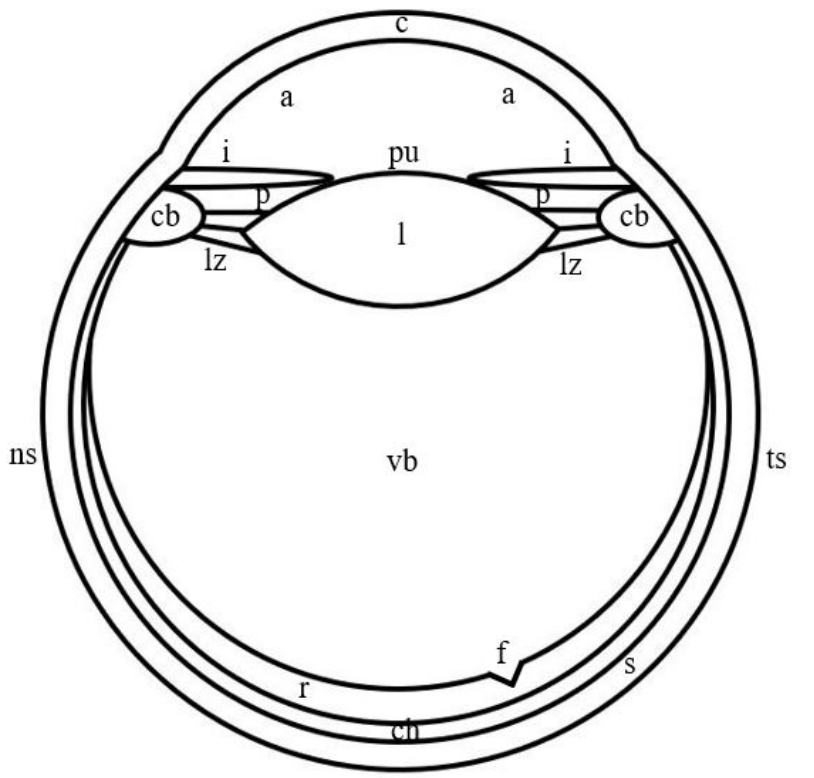
Figure 2. Schematic drawing of the camera-like eye of humans. c: cornea; a: anterior chamber; i: iris; pu: pupil; p: posterior chamber; l: lens; lz: ligament of Zinn; cb: ciliary body; vb: vitreous body; f: fovea; r: retina; ch: choroid; s: sclera; ns: nasal side; ts: temporal side.